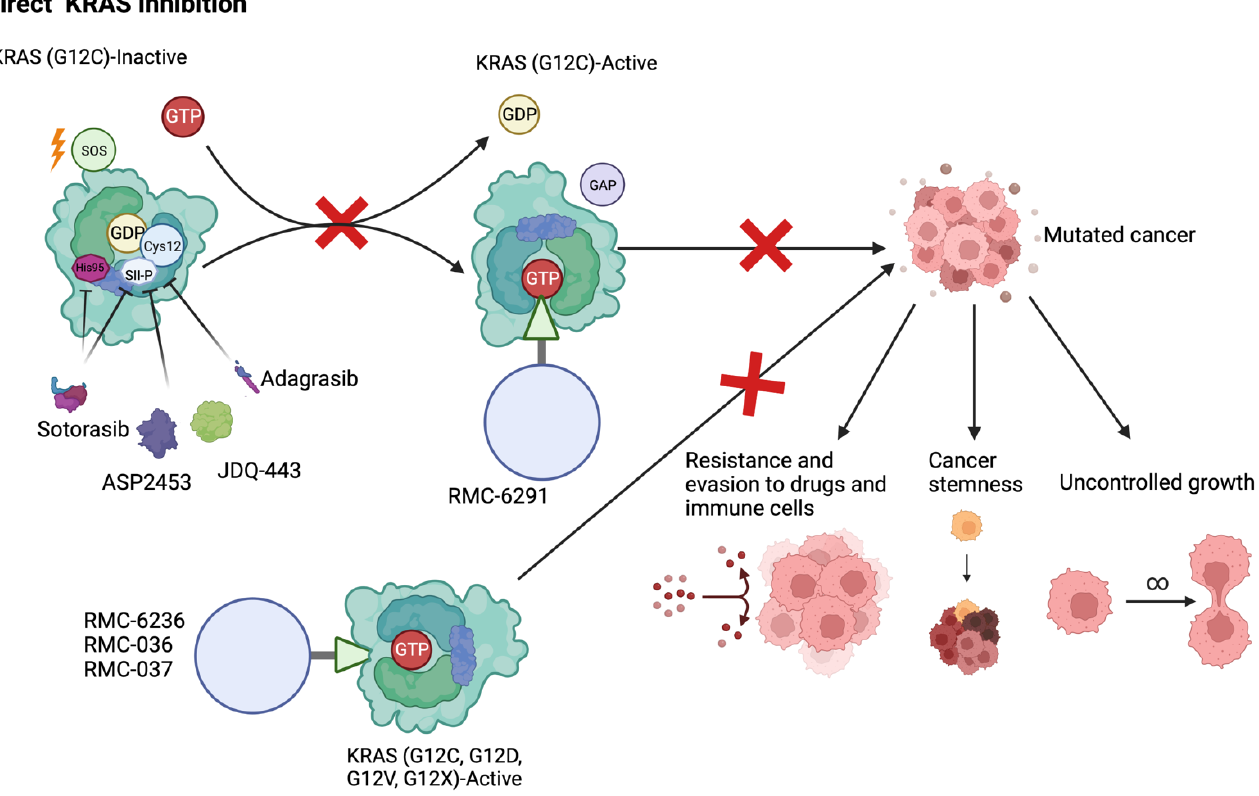
Figure 2. Direct inhibition of KRAS G12C mutation. The listed drugs Sotorasib, ASP2453, JDQ443, and Adagrasib work through a similar mechanism, binding to the mutated Cys12 residue of KRAS mutants. By making contacts with the Switch II pocket (SII-P) region, the inhibitors make a stable connection with KRAS and prevent structural change into its active conformation. Sotorasib uniquely binds to a His95 residue proximal to the SII-P to increase contact with the protein. In doing so, the inhibitors subdue tumorigenic phenotypes including cancer stemness, uncontrolled proliferation, and the ability to evade immune and drug attack. The series of inhibitors from Revolution Medicines, RMC-6291, RMC-6236, RMC-036, and RMC-037, bind instead to the GTP-bound active form of KRAS. Creating a tri-compound structure with Cyclophilin A, the inhibitors can bind G12C and other mutant KRAS proteins.